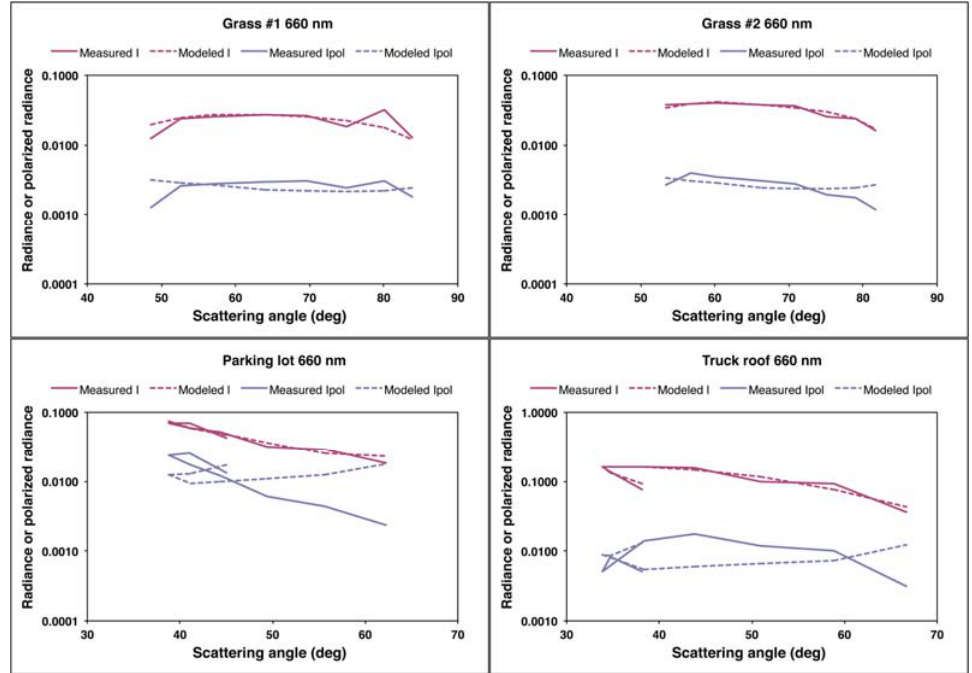
Figure 6. Total and polarized radiances measured by GroundMSPI at 660 nm as a function of scattering angle for the four targets identified in Figure 4 (solid lines), along with fitted values from Step 1 (dashed lines) using the first term of Equation (22) and the uniform facet distribution.